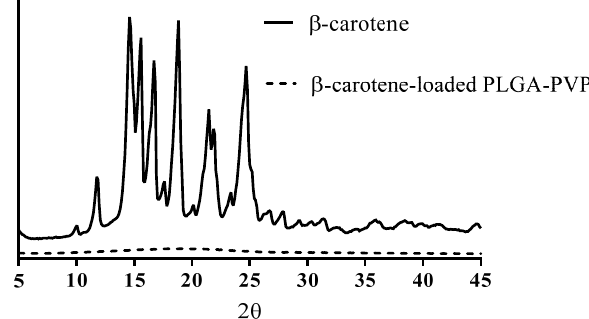
Figure 4. PXRD profiles of β -carotene and its nanoformulations.